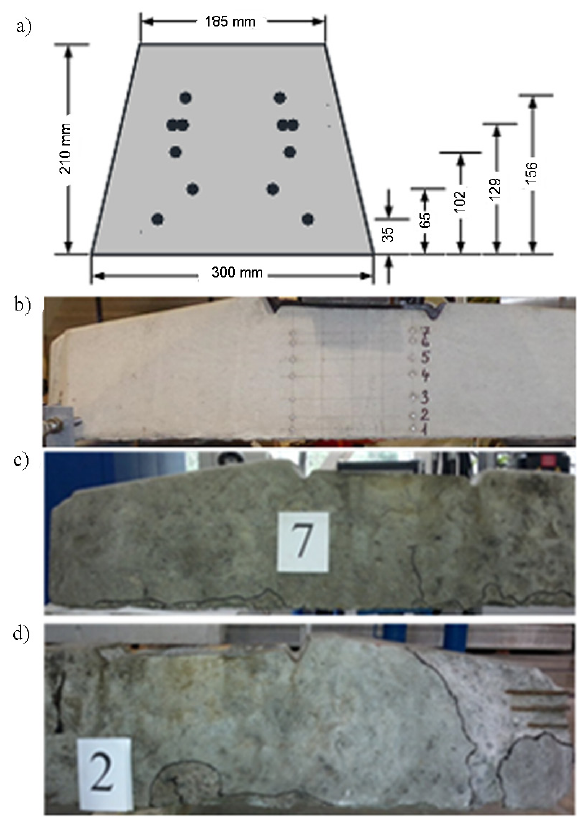
Fig. 2. Prestressed concrete sleepers: a) cross-section; b) new sleeper; c), d) used